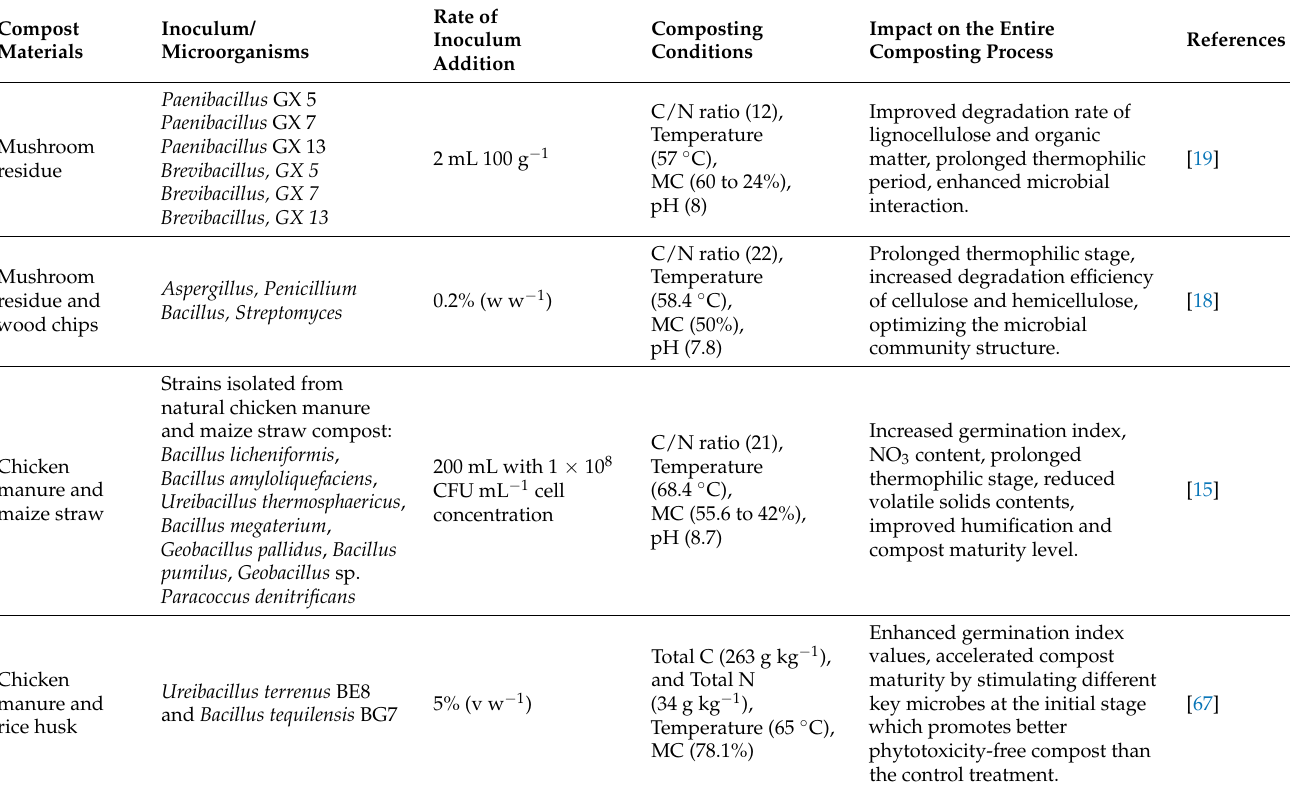
Table 3. Summary of the impact of microbial inoculation on the agro-industrial waste composting by several works of